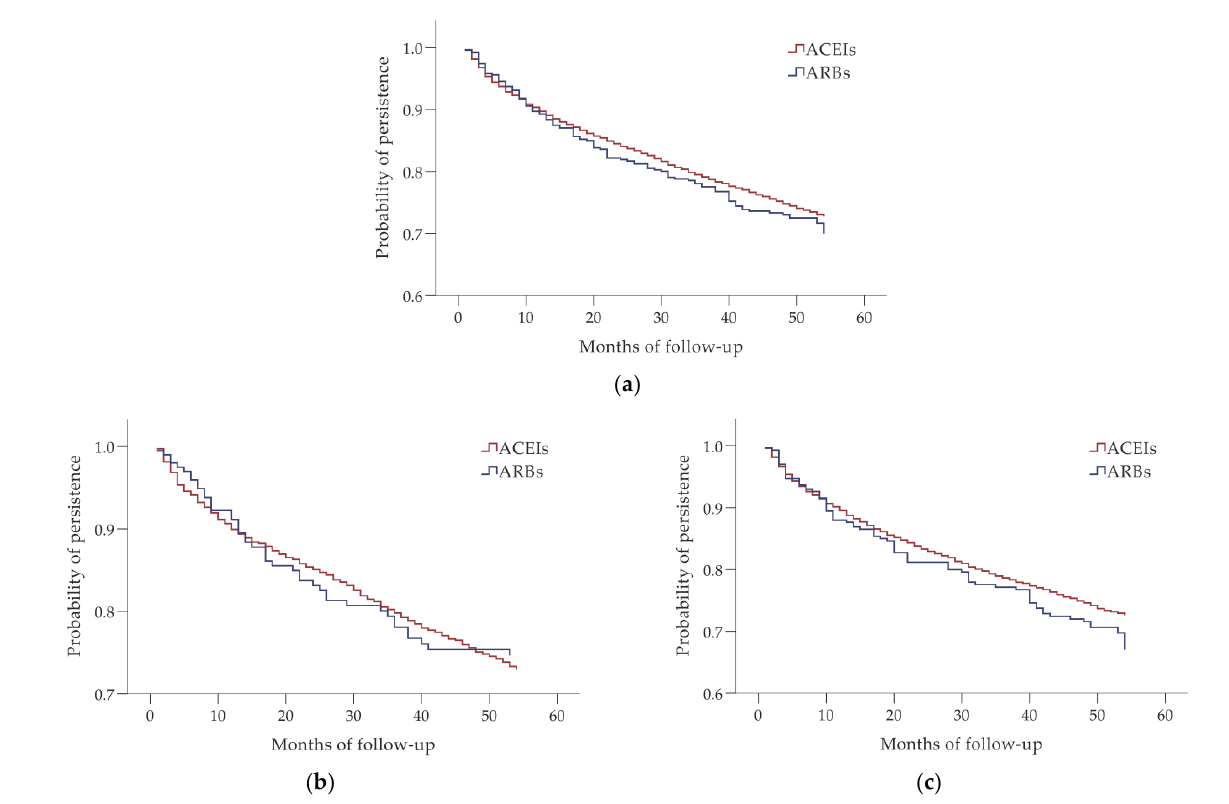
Figure 2. Persistence with angiotensin-converting enzyme inhibitors/angiotensin receptor blockers in males and females.